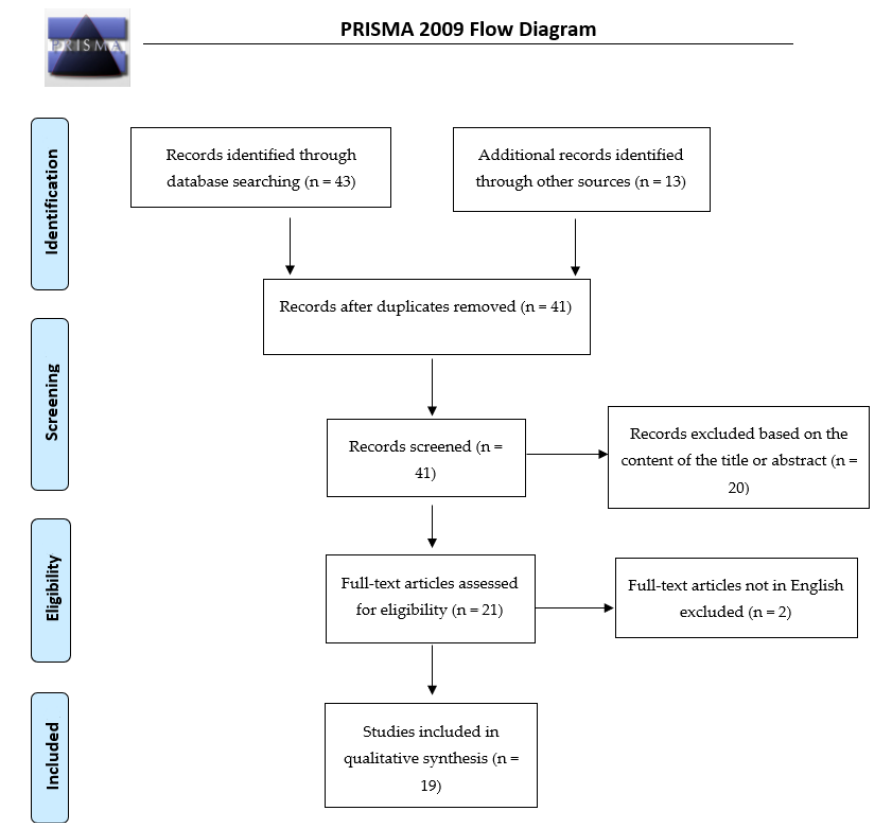
Figure 1. PRISMA 2009 flow diagram.